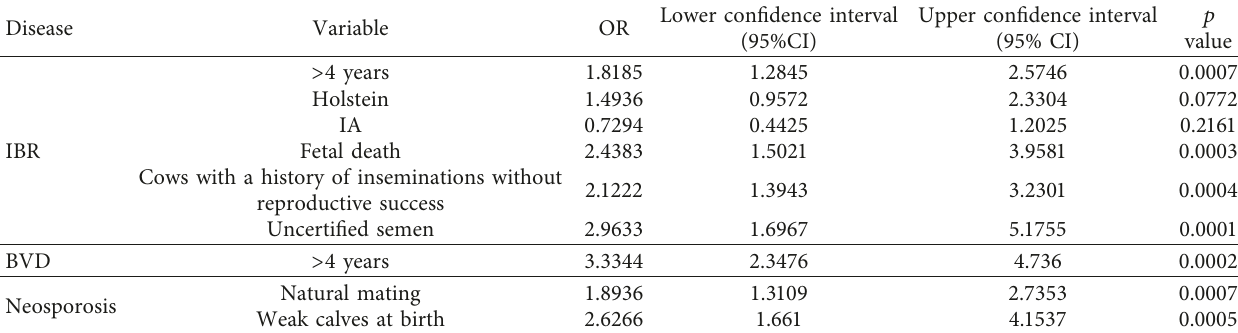
Table 4: Analysis of different variables as possible risk factors for seropositivity to IBR, BVD, PI3, neosporosis, and leptospirosis infections in cattle in Chiquinquir´a,